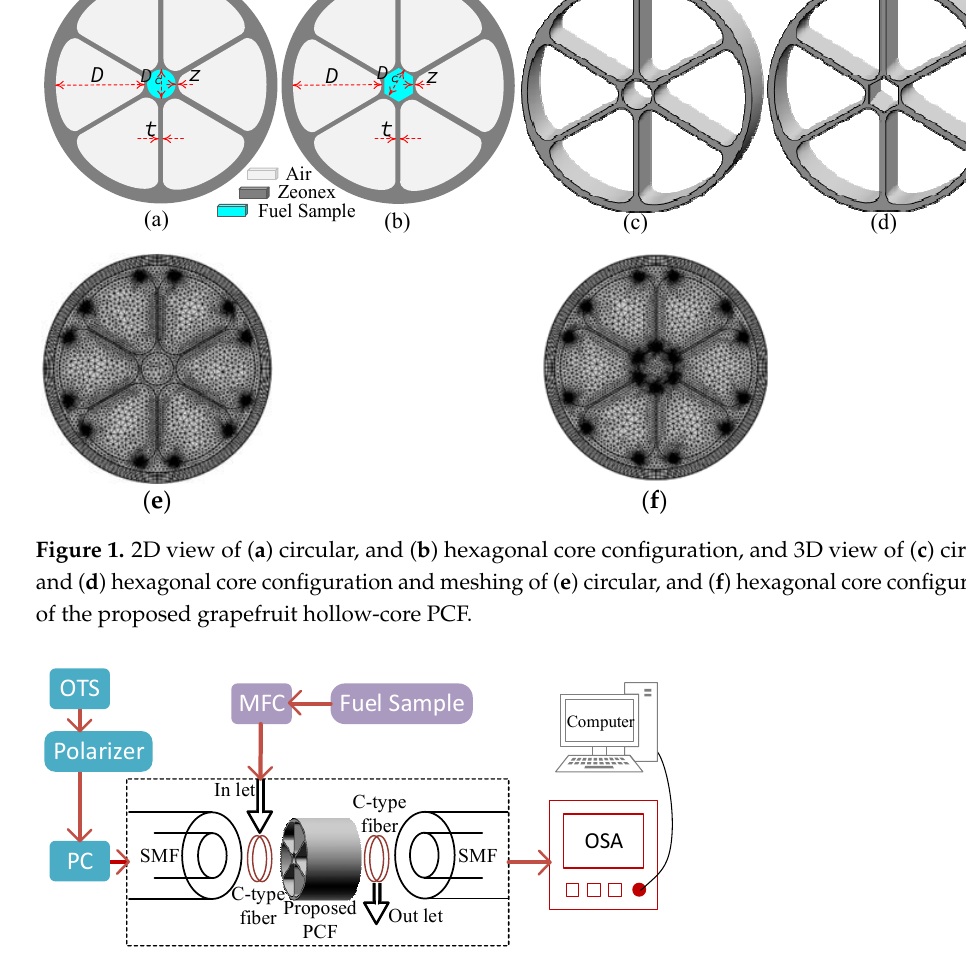
Figure 1. 2D view of ( a ) circular, and ( b ) hexagonal core configuration, and 3D view of ( c ) circular, and ( d ) hexagonal core configuration and meshing of ( e ) circular, and ( f ) hexagonal core configura ‐ tion of the proposed grapefruit hollow ‐ core PCF.